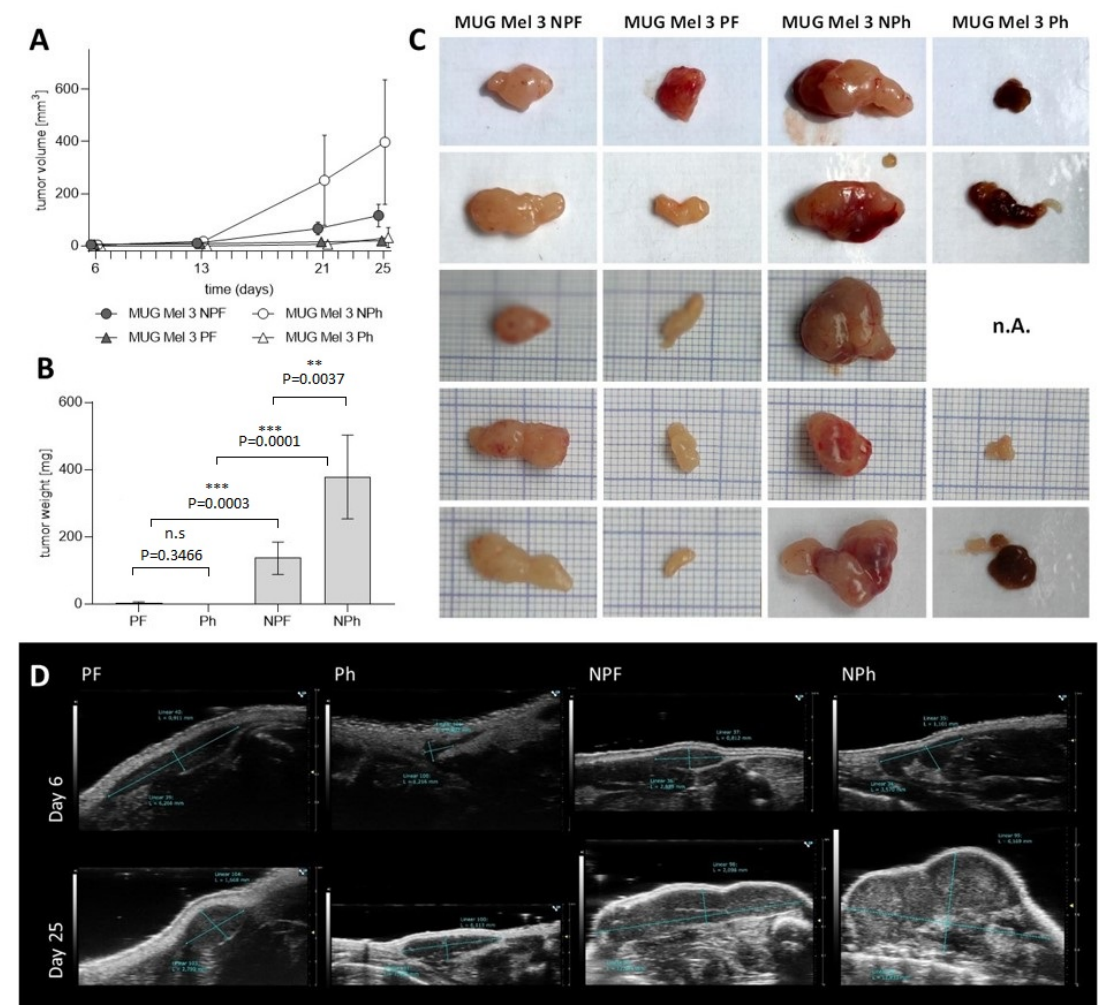
Figure 6. Tumorigenic profile of all four MUG Mel3 cell lines in CR ATH HO nude mice. Tumor volume [mm 3 ] over time—significance was tested by comparing culture conditions (FBS or hPL) within cell lines of origin (pigmented or non-pigmented) and the origins of cells within the same cultivation method on day of sacrifice: MUG Mel3 NPh/MUG Mel3 NPF p -value = 0.0319; MUG Mel3 NPh/ MUG Mel3 Ph p -value = 0.0056; MUG Mel3 PF/Ph p -value = 0.5024 and MUG Mel3 NPF/ MUG Mel3 PF p value = 0.0011—( A ) and tumor weight [mg] on day of sacrifice ( B ) are illustrated ( p ≤ 0.01 = **, p ≤ 0.001 = ***). Excised tumors of all mice are shown in ( C) ( n = 5). High frequency ultrasound (HF-US) images of one representative mouse are presented in ( D ). The images on day six were recorded with a 50 MHz (MX700) transducer; the images on day 25 with a 40 MHz (MX550D) transducer.